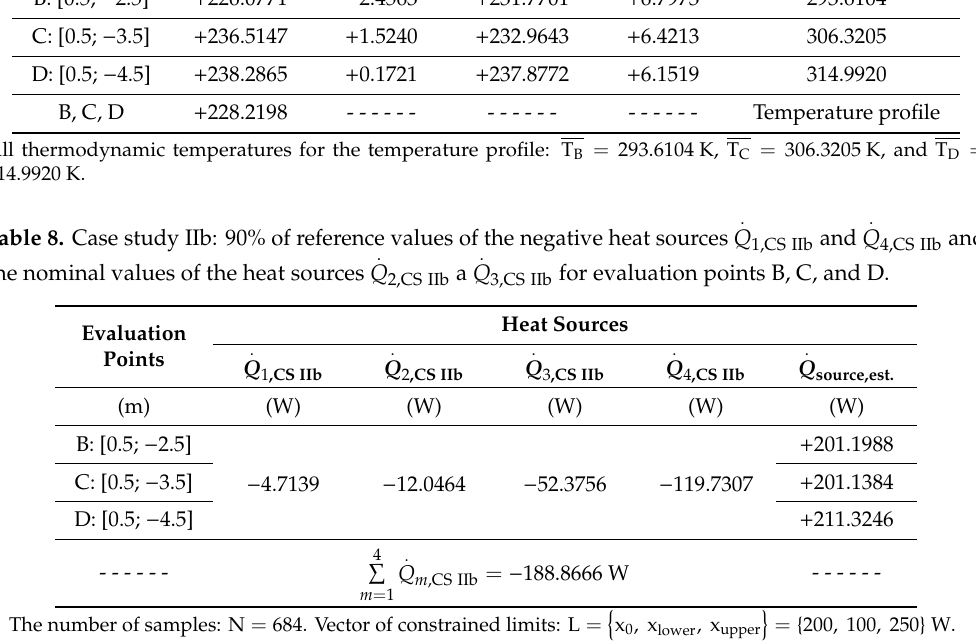
. . Q 1,CS IIb and Q 4,CS IIb and